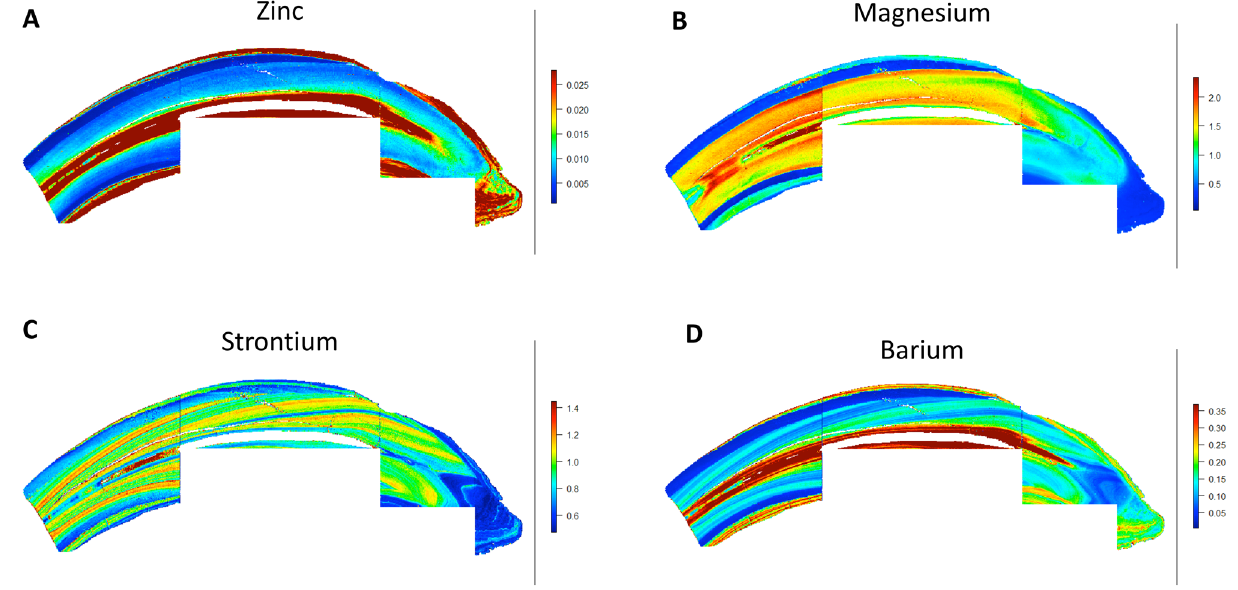
Figure 3. Essential and non-essential elements in equine teeth. Maps for zinc ( A ), magnesium ( B ), strontium ( C ), and barium ( D ) are shown. The essential elements zinc ( A ) and magnesium ( B ) did not show a banding pattern while non-essential elements, strontium ( C ) and barium ( D ) showed a banding pattern similar to that observed with